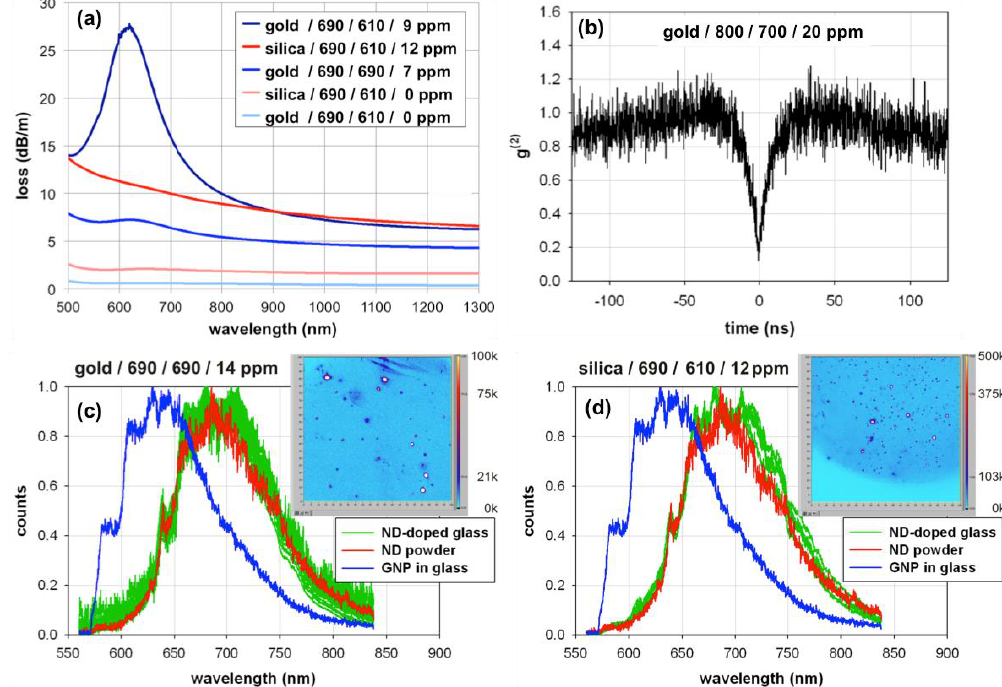
Figure 3. ( a ) Light attenuation spectra of nanodiamond (ND)-doped and undoped Na-Zn-tellurite (TZN) fibers; ( b ) background-corrected second order autocorrelation function g (2) of nitrogen-vacancy (NV) emitters in ND-doped Na-Zn-La-tellurite (TZNL) fiber; ( c , d ) confocal microscope images and fluorescence spectra of emitters in ND powder and ND-doped TZN tellurite fiber samples and of gold nanoparticles (GNPs) in TZN tellurite glass. The legends indicate crucible material/batch melting temperature in °C/doping temperature in °C/ND doping concentration.